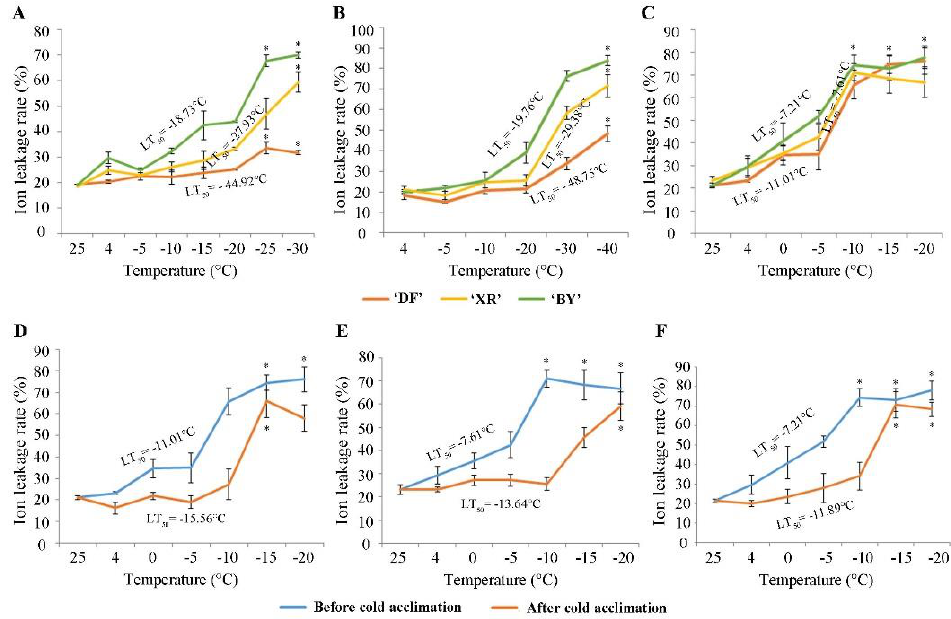
Figure 3. Changes in ion leakage rates and effects of cold acclimation of DF, XR, and BY. Adult trees before ( A ); and after ( B ) winter. Grafted seedlings of three varieties ( C ); and each variety before and after cold acclimation: ( D ) DF; ( E ) XR; and ( F ) BY. p < 0.05, marked by *.